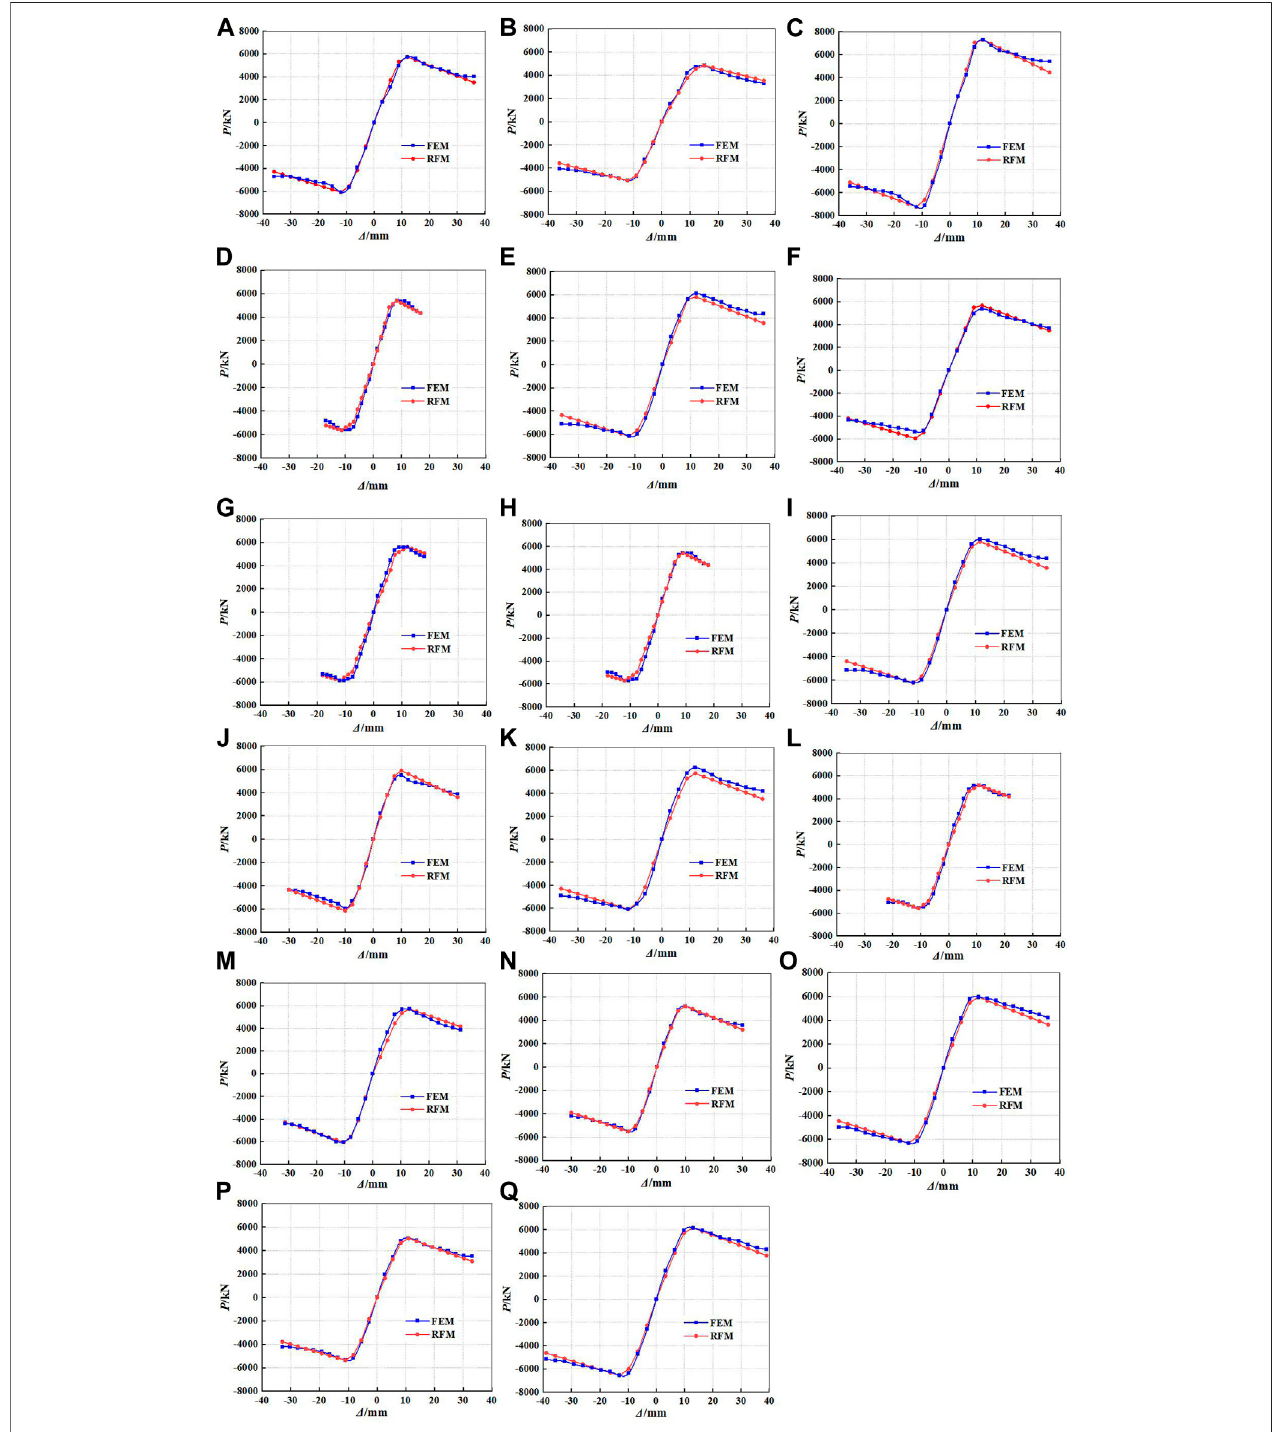
FIGURE14| ComparisonsofskeletoncurvesbetweenRFMandFEM: (A) GRS-1; (B) GRS-2; (C) GRS-3; (D) GRS-4; (E) GRS-5; (F) GRS-6; (G) GRS-7; (H) GRS- 8; (I) GRS-9; (J) GRS-10; (K) GRS-11; (L) GRS-12; (M) GRS-13; (N) GRS-14; (O) GRS-15; (P) GRS-16; and (Q) GRS-17.